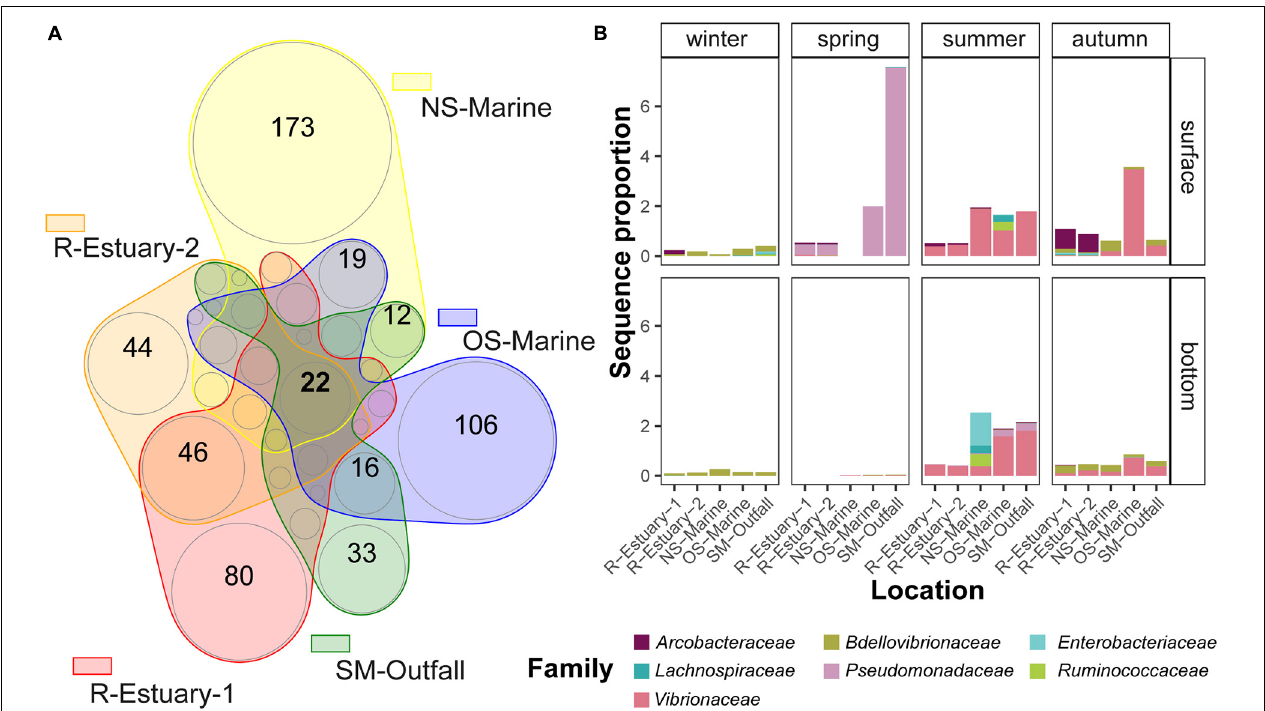
FIGURE 7 | Visualization of bacterial community relationships between different stations based on the presence/absence of ASVs belonging to microbial indicators in the 2018/2019 data set using a Venn diagram (A) . The insert circles are approximately proportional to the number of ASVs in each region. The numbers of shared ASVs between stations that are lower than 10 are not shown. Graph (B) represents the sequence proportion of bacterial indicators that were shared among all